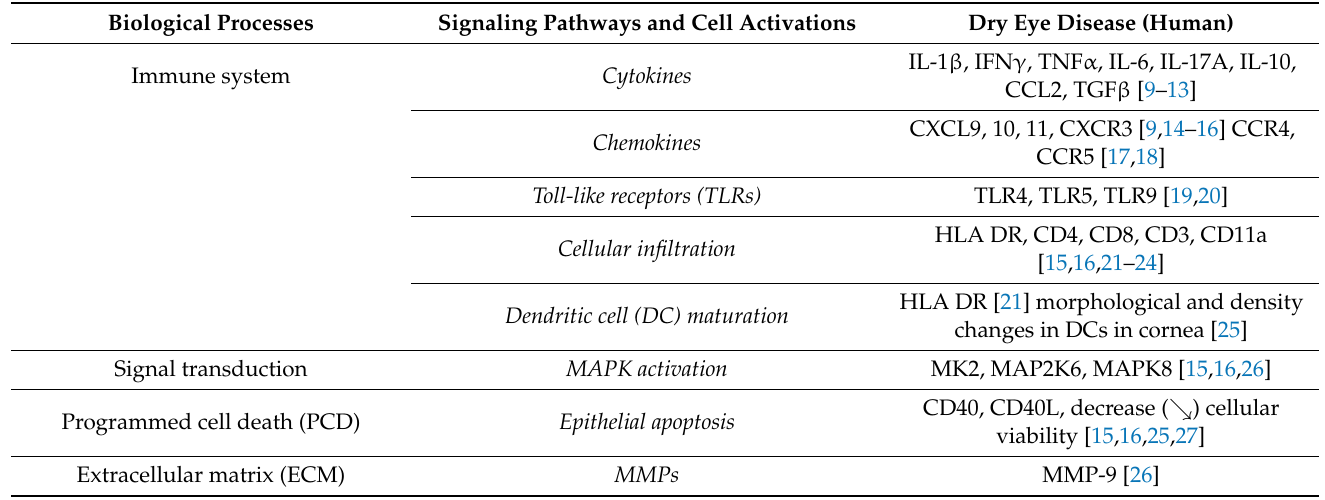
Table 1. Summary of current biological processes and molecular mediators involved in human dry eye